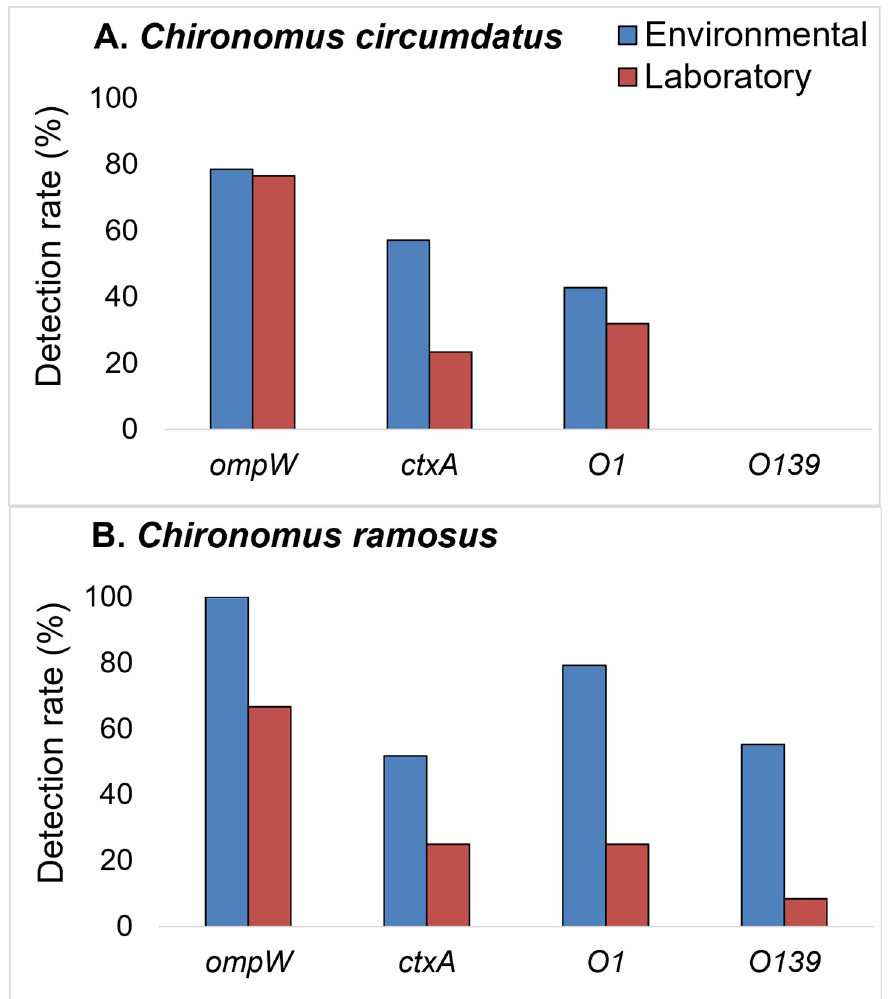
Fig 3. The presence of V . cholerae ( ompW ), the toxigenic strains (O1, O139), and cholera toxin subunit A ( ctxA ) in chironomid environmental samples vs. laboratory samples. The figure presents the prevalence of these genes in the two dominant Chironomus species ( C . circumdatus and C . ramosus ), identified in India.